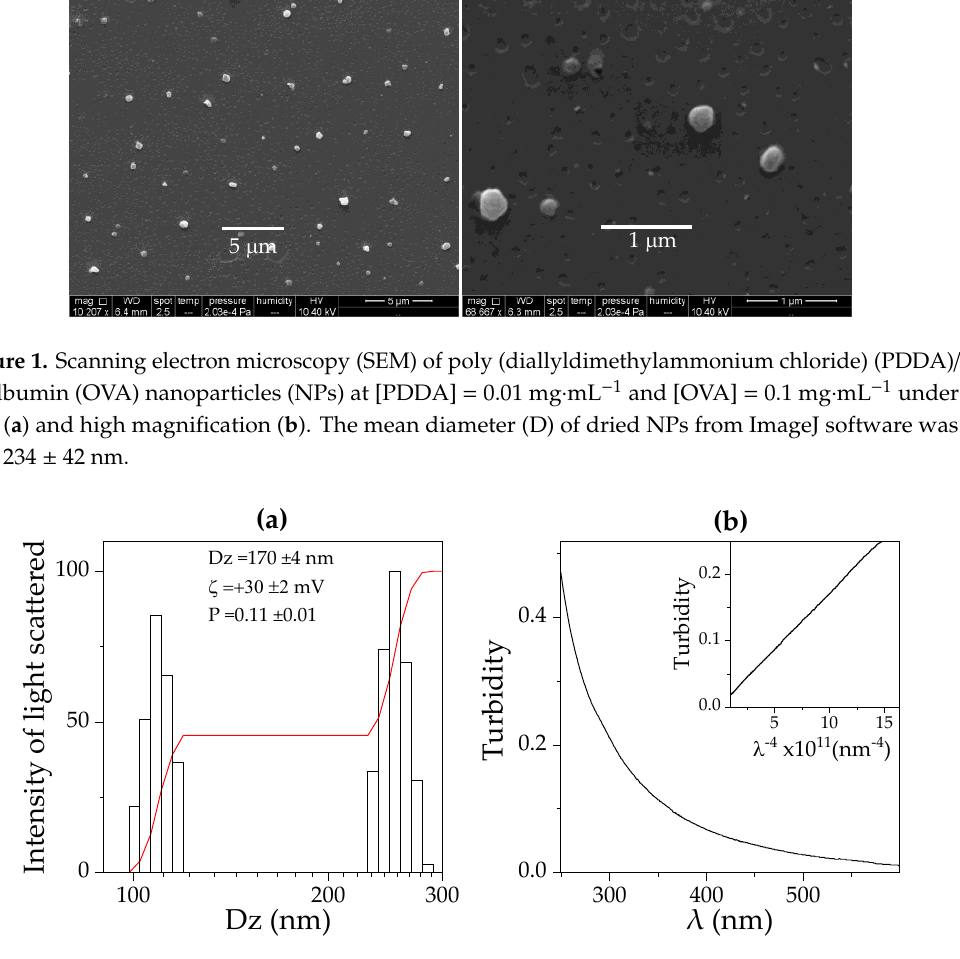
Figure 2. Intensity of light scattered by PDDA/OVA NPs in water obtained at 0.01 PDDA and 0.1 mg·mL −1 OVA: (a) as a function of the hydrodynamic diameter (Dz) determined by dynamic light scattering (DLS); (b) as a function of wavelength of the incident light (λ) determined from turbidimetry. Mean Dz, zeta potential (ζ), and polydispersity (P) for this dispersion are also given. The relationship between turbidity and λ −4 was linear with a regression coefficient of 0.90 (insert).